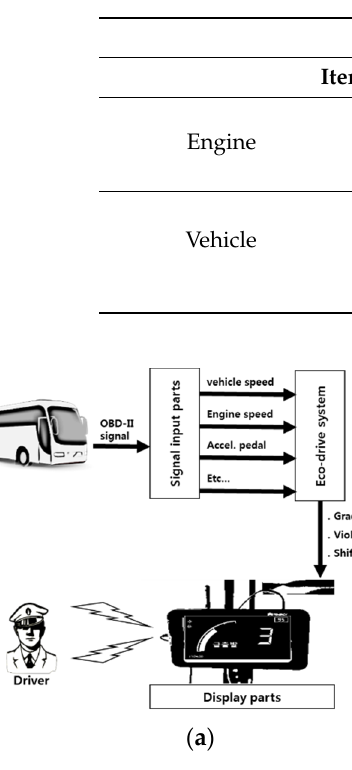
Figure 7. Eco-drive system: ( a ) eco-drive system schematic; ( b ) eco-drive system display layout.